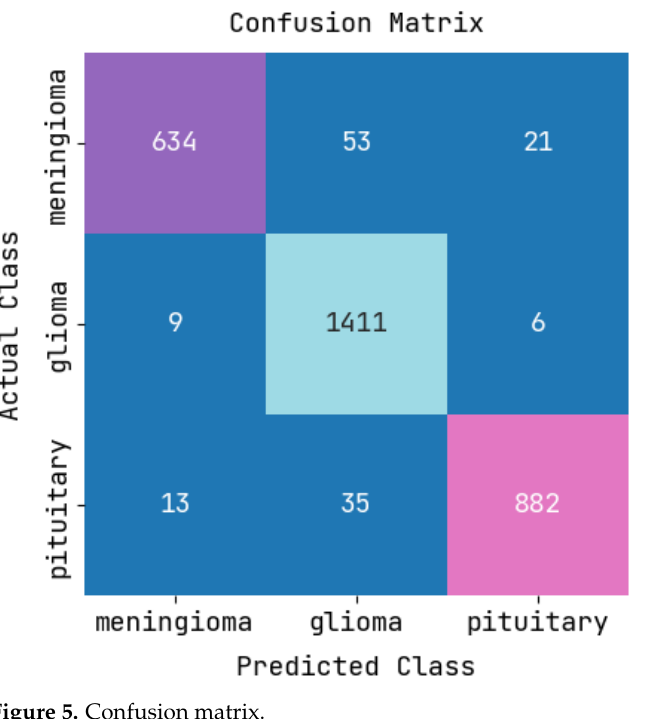
Figure 6. Precision–recall curve correlation. Figure 7 illustrates the precision–recall curve, in which the X-axis exhibits the FP rate, and the Y-axis exhibits the TP rate. During this procedure, the proffered methodology attained an AP of 0.9919 for meningioma, 0.9954 for glioma, and 0.9964 for pituitary tu- mors, exhibiting the fine precision and recall VGG16_CNN.